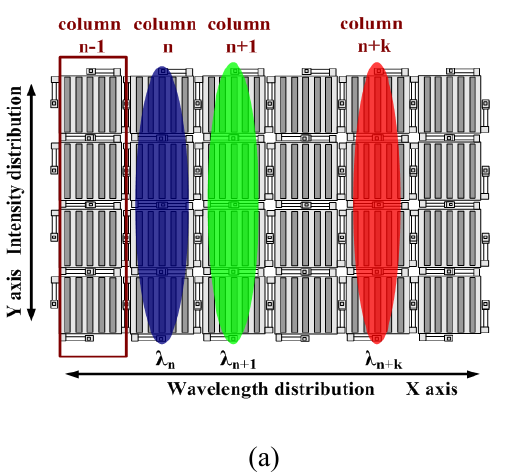
Figure 4. (a) Diffracted light incident on a GLM array chip. (b) Spectrum sampling by GLM